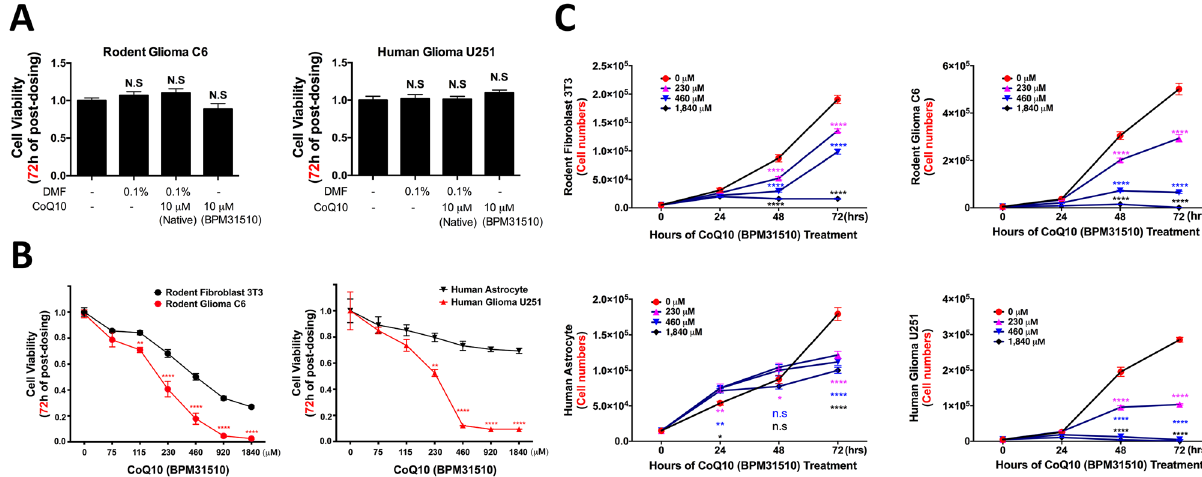
Figure 1. Differential effects of oxidized CoQ 10 on glioblastoma and non-tumor cell lines. ( A ) Relative cell viability of rodent C6 glioma and human U251 glioma cells after exposure to 0.1% DMF, 10 µM native CoQ10 (in 0.1% DMF), or 10 µM of ubidecarenone using BPM31510 for 72 h. Values are normalized to control. No significant effect on cell growth is noted under any condition. ( B ) Dose response curves for rat C6 glioma and mouse NIH3T3 fibroblast cells (left panel) and human U251 glioma and HA cells (right panel) after incubation for 72 h with BPM31510. Note that in each case, the tumor line was more sensitive than the control. ( C ) Cell viability analysis of each cell line over time after incubation with increasing doses of ubidecarenone. The number of live cells is converted from a pre-established standard curve with known cells numbers. All data presented as Mean ± SEM. *P < 0.05, **P < 0.01, ***P < 0.001, ****P < 0.0001 compared to control (no BPM31510) counts on the same day. Each color corresponds to the BPM31510